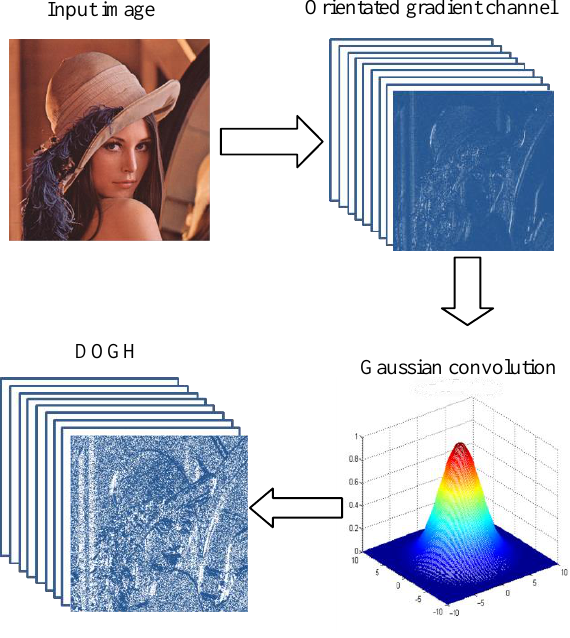
Figure 2 Processing chain of